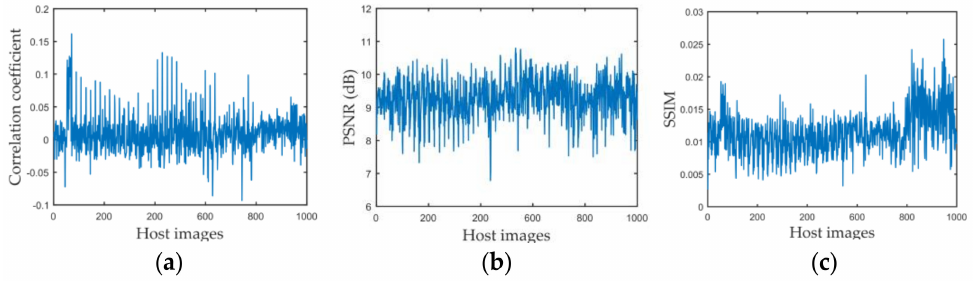
Figure 16. Evaluation of proposed encryption method. ( a – c ) are correlation coefficients, PSNR and SSIM values,